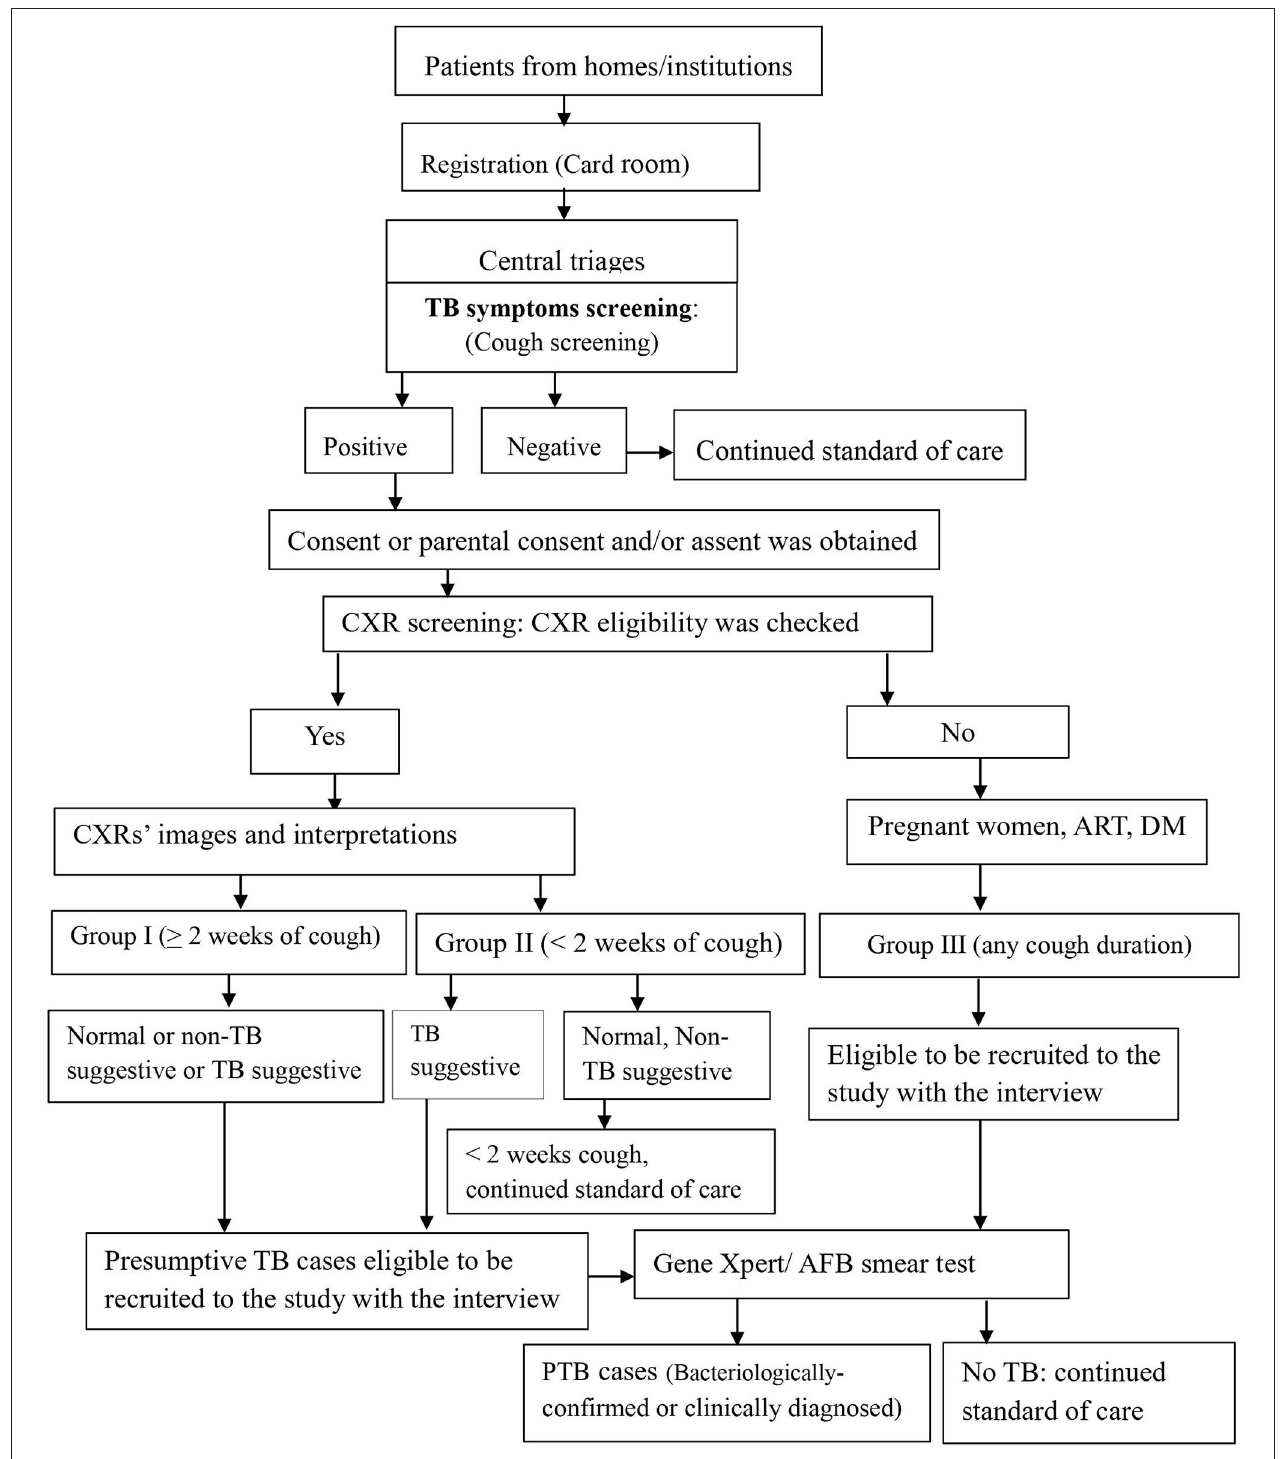
FIGURE 1 | Screening, recruitment, and diagnosis workflow for PTB at health facilities, Ethiopia. RCH, Reproductive and child health; OPD, outpatients department; DM, Diabetic mellitus; CXR, Chest X-ray; PTB, pulmonary tuberculosis; AFB, Acid fast bacillus.